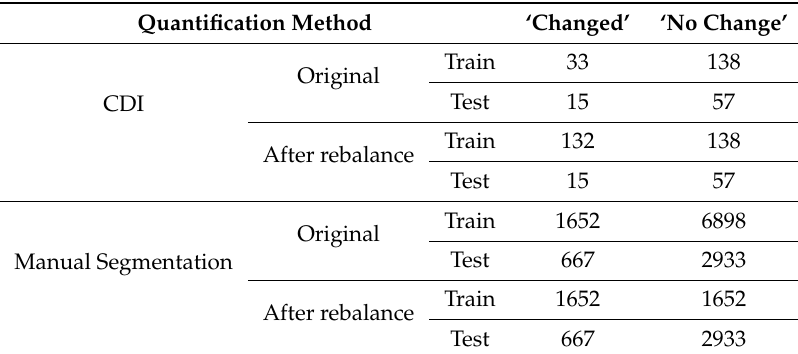
Table 1. Sample distribution in experiment 1.